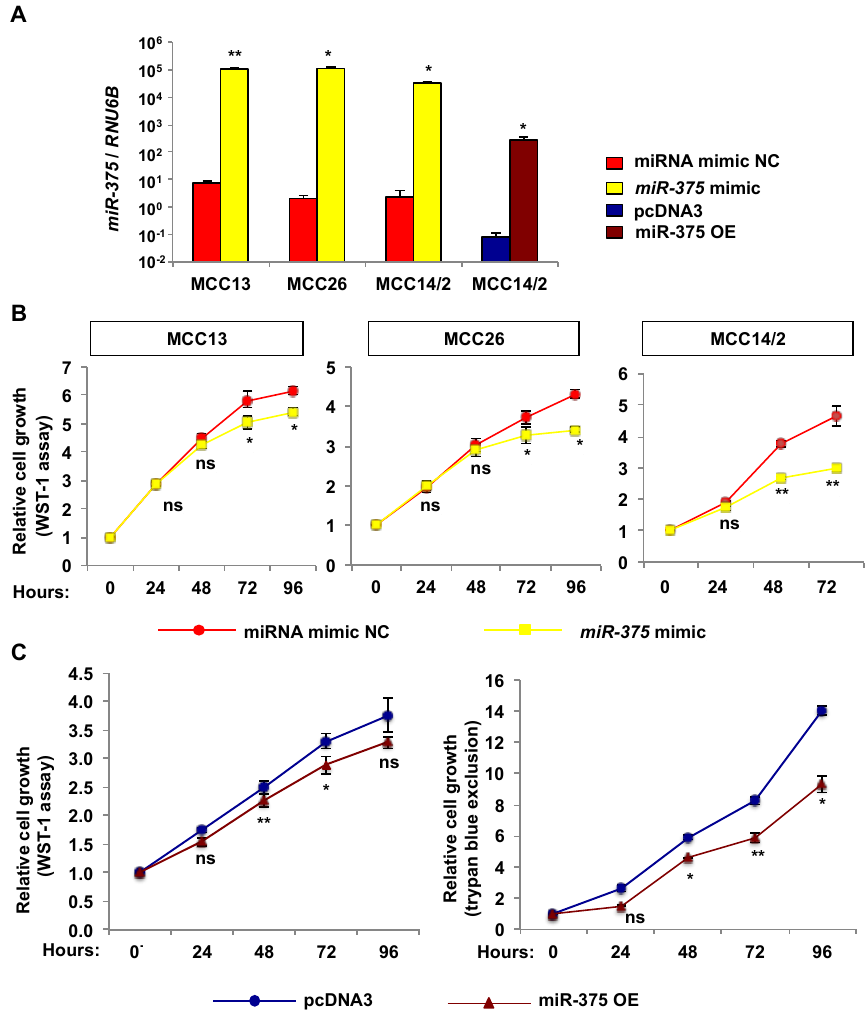
Figure 3. Over-expression of miR-375 reduces cell growth in MCPyV − MCC cell lines. MCPyV − MCC cells were transfected with miR-375 mimic or miR-375 OE and their respective negative controls. ( A ) Quantification of miR-375 in the transfected cells after 48 h of transfection or stable miR-375 OE-transfected cells of MCC14/2 by RT-qPCR. The relative expression of miR-375 was normalized to RNU6B and compared to miRNA mimic negative control (NC) or vector control (pcDNA3). ( B ) Evaluation of cell growth in cells transfected with miR-375 mimic and miRNA mimic NC at different time points using WST-1 assay. ( C ) Cell growth in stable miR-375 OE-transfected cell line was evaluated at different time points using WST-1 and trypan blue exclusion assays. Error bars are SEM from three independent experiments. * p < 0.05 and ** p < 0.01 by paired Student’s t -test. ns = not significant.